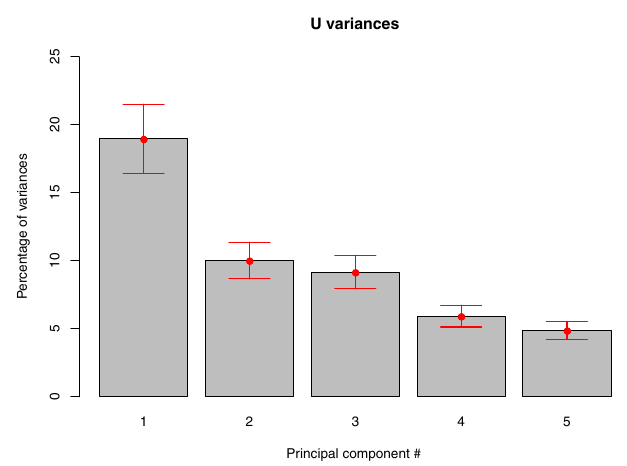
Figure 3. Proportions of the total variance (%) associated with the leading five EOFs for the 200hPa zonal wind field of ERA-Interim reanalysis. Error bars are estimates of sampling errors in EOF com- putation according to “North’s rule of thumb” (North et al., 1982).